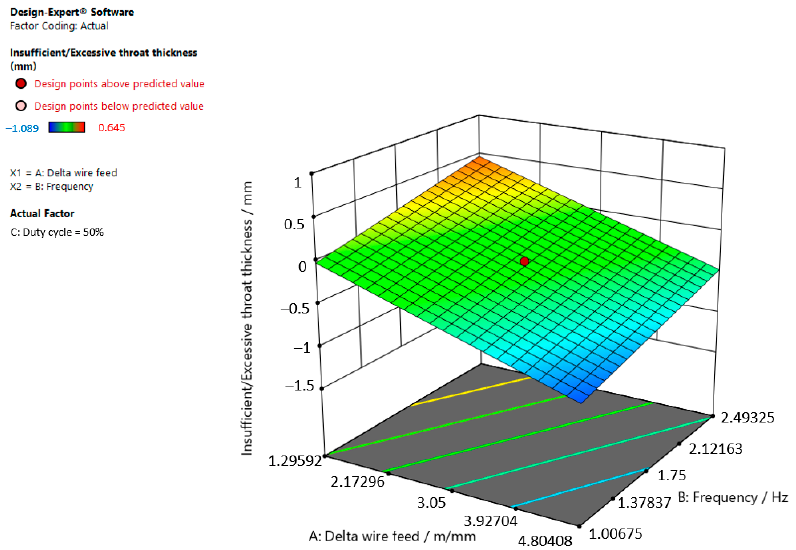
Figure 3. Response surface for the regression model of insufficient/excessive throat thickness at a duty cycle of 26.216%.